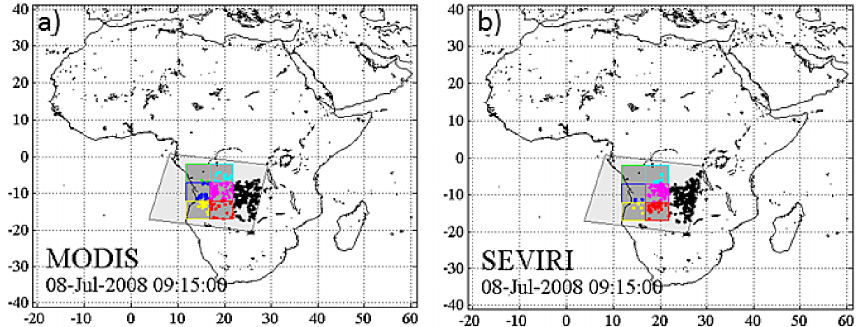
Figure 6. Graphical representation of the procedure used to generate the data set for use in evaluating the bias adjustment factors used within the FRP-GRID product. Fire pixels were subset from the MOD14 and MYD14 MODIS active fire products available between May 2008 and April 2009 using six 5.0 ◦ grid cells centred on the MODIS swath, as illustrated in (a) . These same grid cells were then used in (b) to subset fire pixels from the SEVIRI full Earth disk images acquired at times coincident with the MODIS overpass, as well as from the three previous SEVIRI imaging time slots collected prior to the MODIS